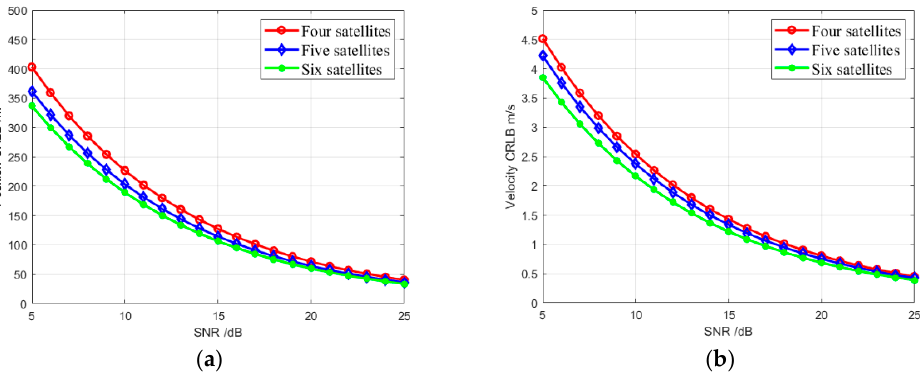
Figure 2. CRLB of joint localization and motion parameter extraction method. ( a ) Position CRLB versus the different number of satellites. ( b ) Velocity CRLB versus the different number of satellites.